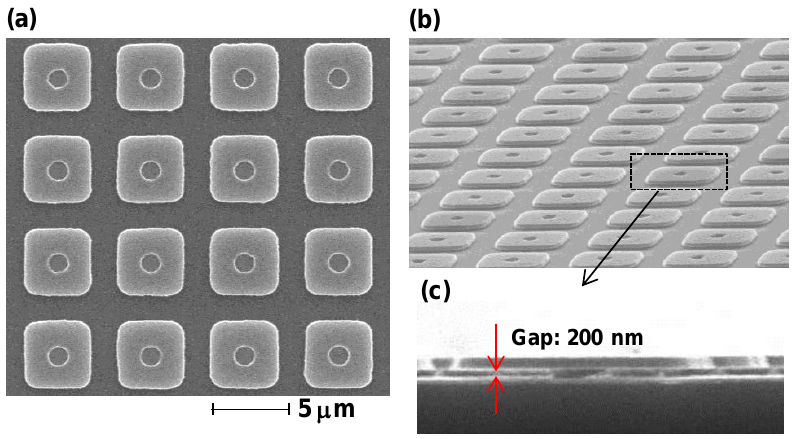
Figure 4. SEM images of an MPMAT: ( a ) top; ( b ) oblique and ( c ) magnified cross-sectional views of the periodic structures.